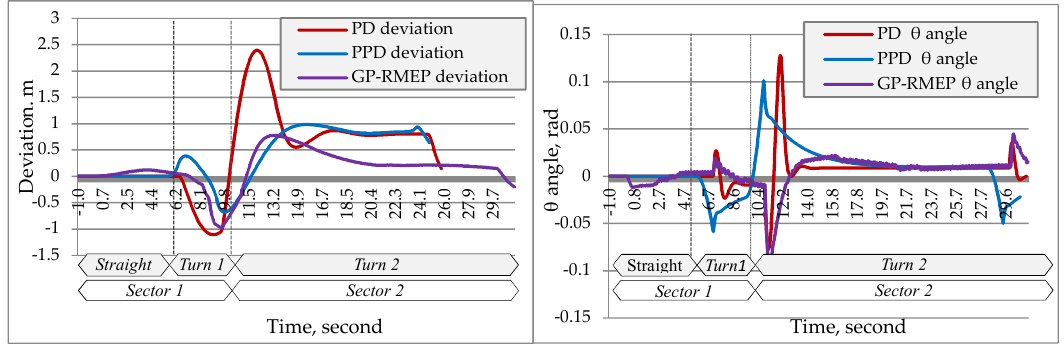
Figure 13. Distance error (left picture) and yaw angle error (right picture) with 0.95 V cr and 0.3 µ .